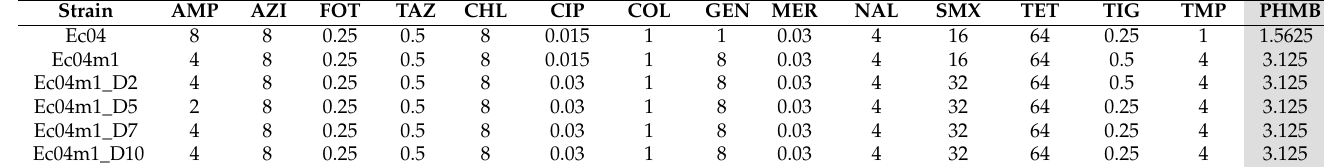
Table 1. Minimal inhibitory concentrations (MIC, mg L − 1 ) for 14 antibiotics and PHMB in Ec04 and derivatives.